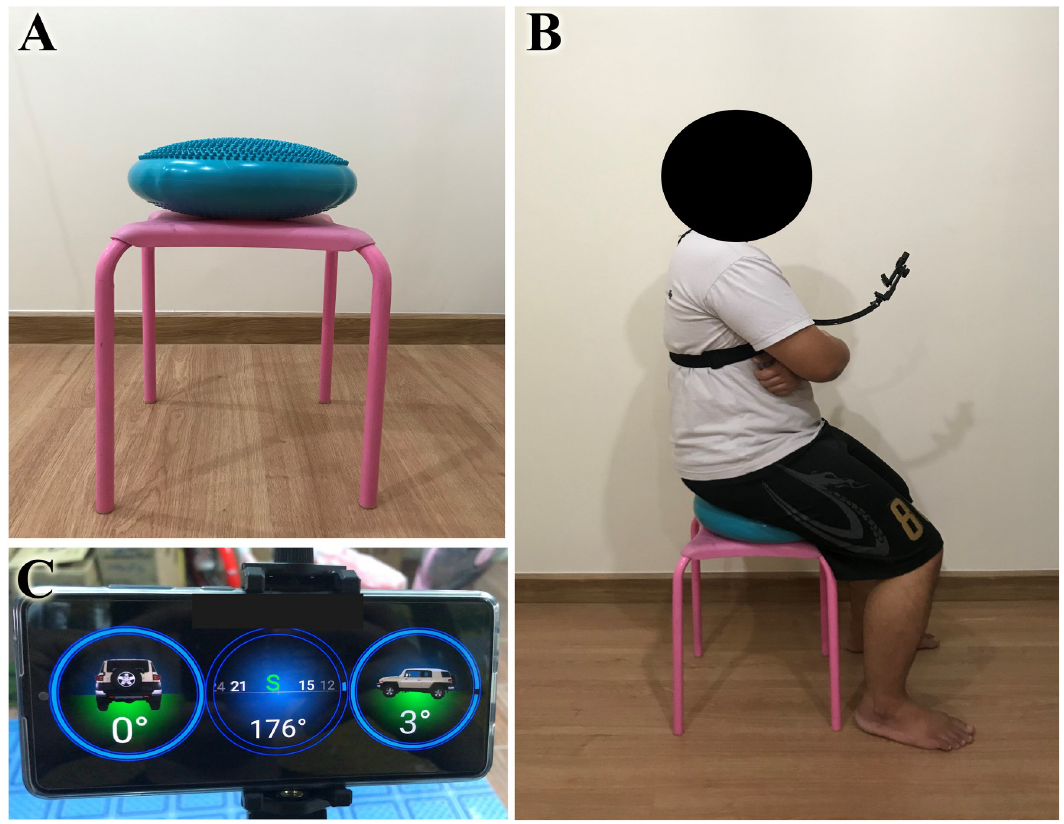
Fig 2. Setup of a home-based exercise using balance disc and smartphone inclinometer application. (A) A balance disc and chair. (B) Starting position. A chest strap and an extension arm were used to secure the smartphone to the participants’ chests. (C) The Compass Inclinometer